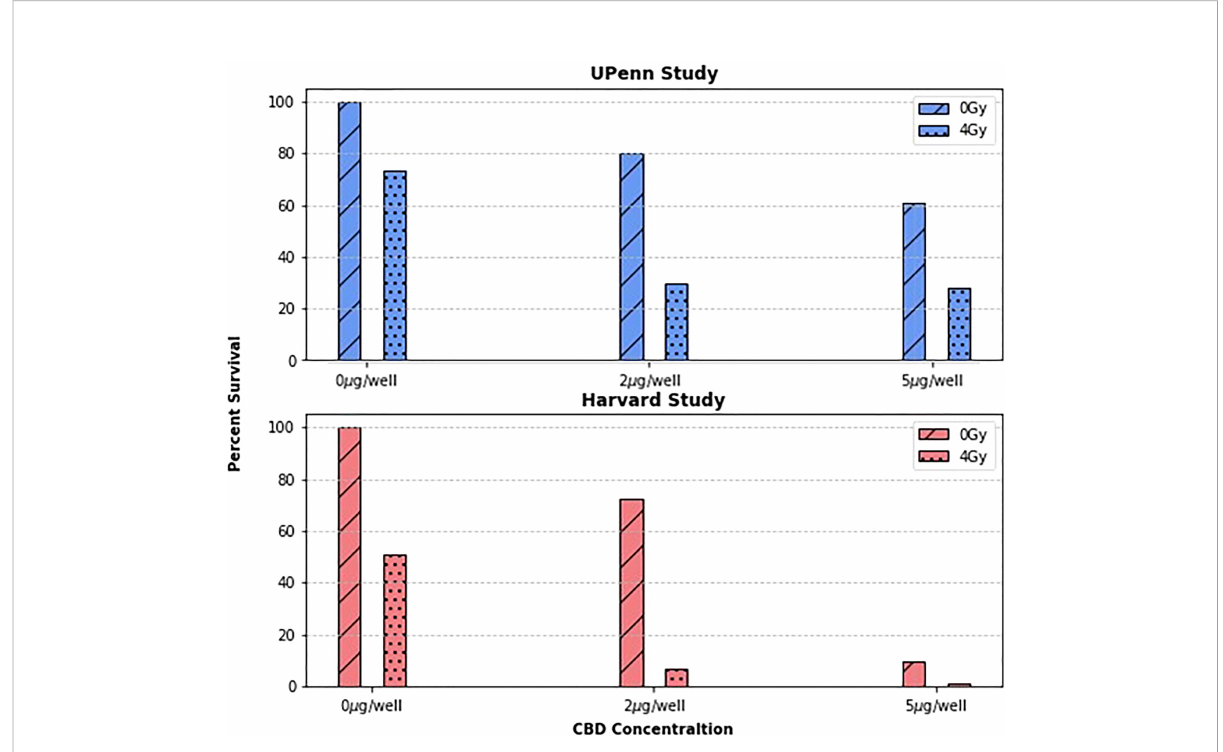
FIGURE 1 The surviving fraction at concentrations of 0, 2, and 5µg/well and dose levels of 0 and 4Gy were compared between two research groups. As expected, the surviving fractions vary quantitatively between groups, but both group ’ s data suggests a clear trend: that treating cancer cells with CBD enhances their